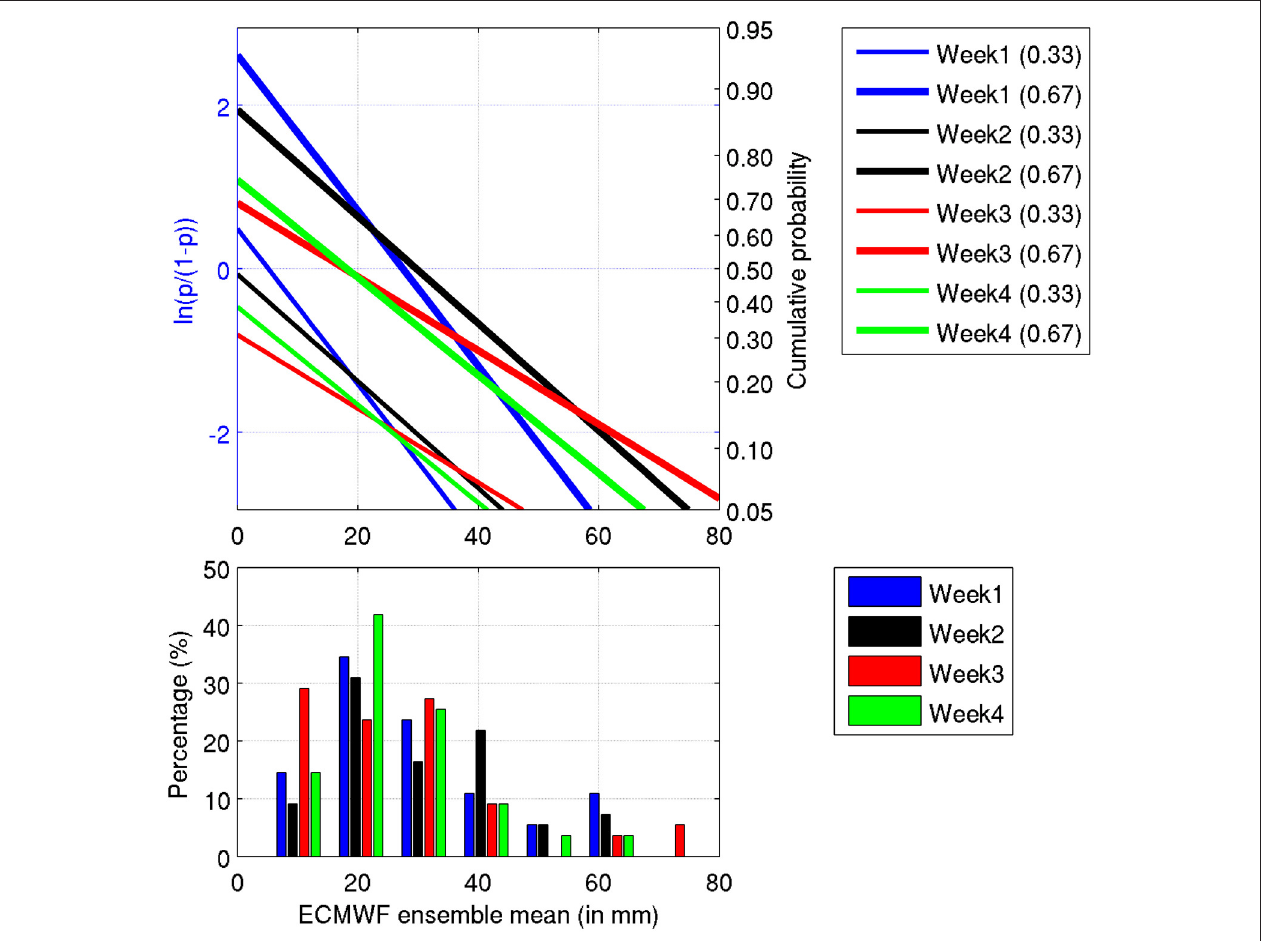
FIGURE 1 | Extended Logistic Regressions plotted for ECMWF hindcasts issued Aug 3rd 2000 at [13.5 ◦ N;91.5 ◦ W] and fitted using 3-week windows over 11 years for terciles definition and training. Forecasted probabilities of non-exceedance of the 0.33 (thick lines) and 0.67 (thin lines) quantiles respectively computed from Equation (1) for different values of the ensemble mean weekly accumulated precipitation forecasts (x axis, in mm) are shown by parallel lines at different leads (week 1–4) yielding to logically consistent sets of forecasts. The distribution of ECMWF ensemble mean weekly rainfall over the 1999–2010 period at this gridpoint is plotted as bins centered on integer multiple of 10 in the lower panel for the respective